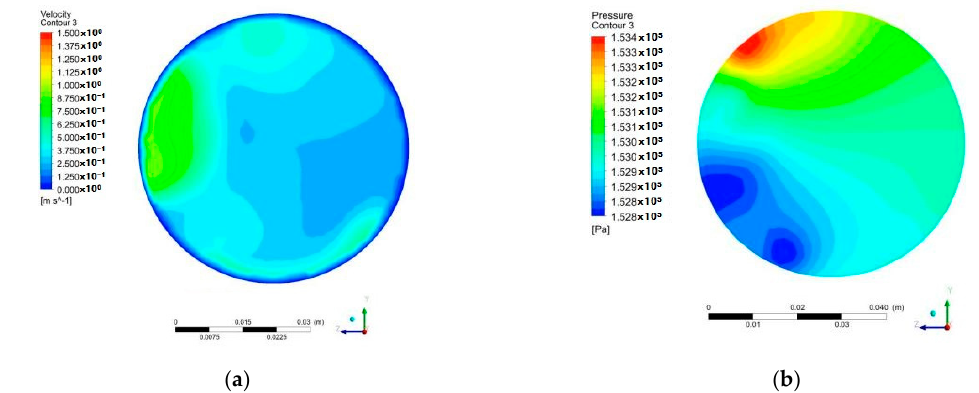
Figure 18. Velocity and pressure distribution in the outlet plane. ( a ) Radial velocity distribution in the outlet section; ( b ) outlet section pressure distribution.